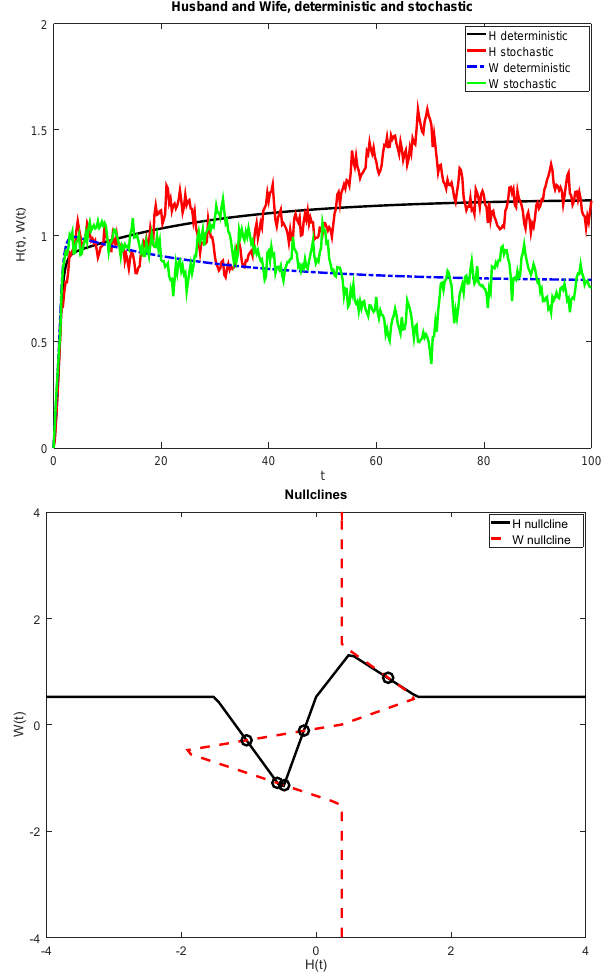
Figure 7. Piece-wise linear influence functions. Plot of H and W vs. time for the deterministic case and a stochastic realization with initial values H 0 = 0, W 0 = 0 (top ) and a plot of the nullclines and the equilibrium points ( bottom